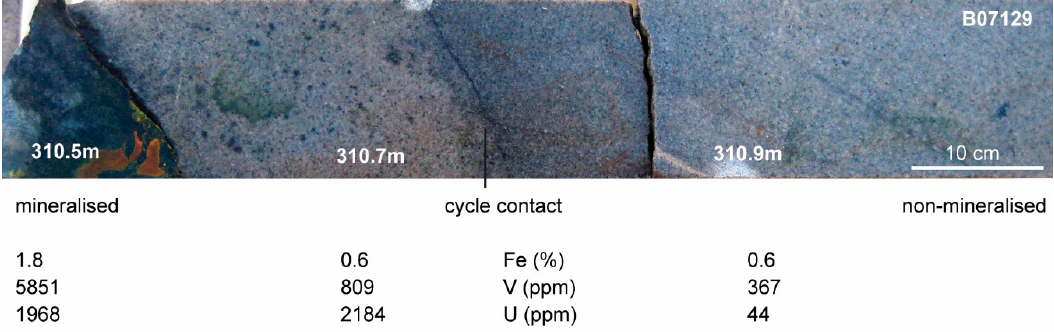
Figure 7. Portable XRF measurements across a cycle contact (drill core B07129—A4) at an erosional surface with the U-V-mineralized zone occurring in coarse-grained, arkosic sandstone just above the channel base. Elevated V levels are present in fine-grained sandstone of the underlying cycle top (V-halo).